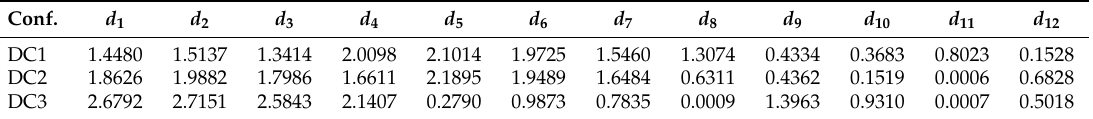
Figure 5. Damping configuration DC1. Full-linked distributed damping system (DDS) with three actuated buildings, ˆ n = 8 interstory dampers and ˜ n = 4 interbuilding dampers. Table 1. Values of the damping coefficients corresponding to the linked damping configurations DC1, DC2 and DC3 ( 10 7 ×